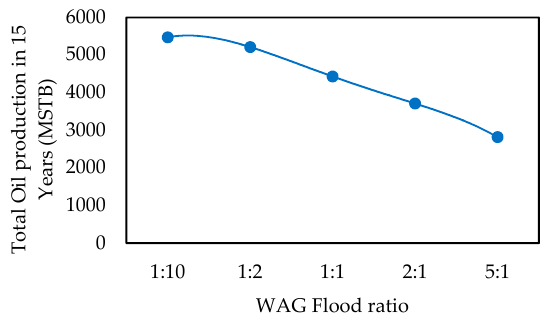
Figure 12. Variation of oil production with WAG flood ratio.